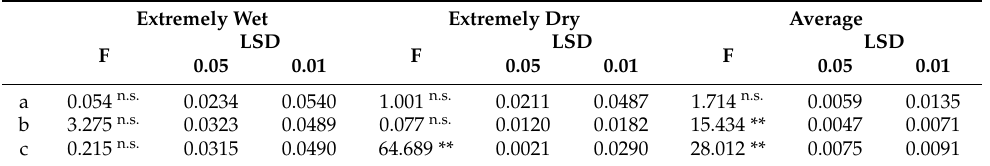
Table 6. Significance of irrigation, N fertilizer rate, and sampling time for soil N level. Extremely Wet Extremely Dry Average